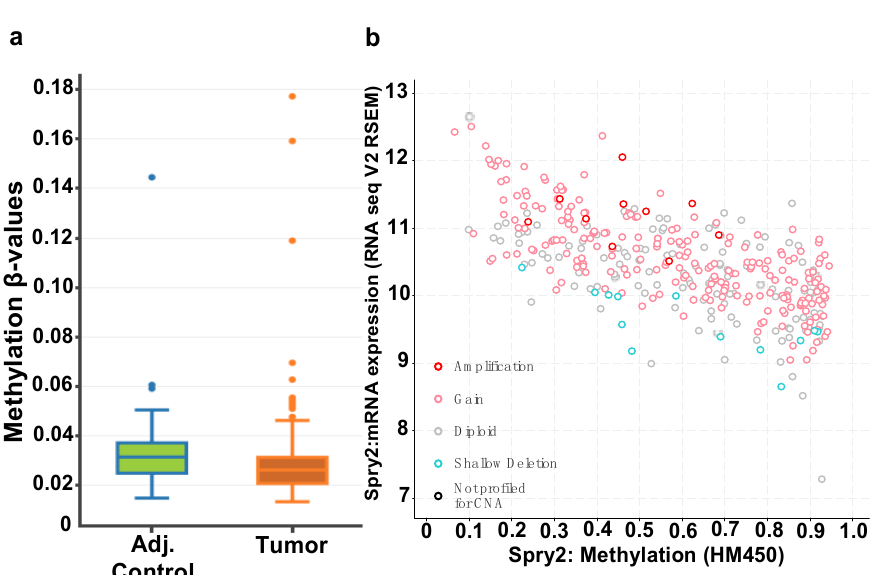
Figure 2. ( a ) DNMIVD figure displaying decreased promoter methylation-beta values in colon tumor compared to normal mucosa ( p -value < 0.05). ( b ) cBioPortal’s database showcasing an inverse correlation of decreased promoter methylation-beta values with increased mRNA expression ( n = 372) (Spearman: p -value = 8.21 x 10 -48 ).